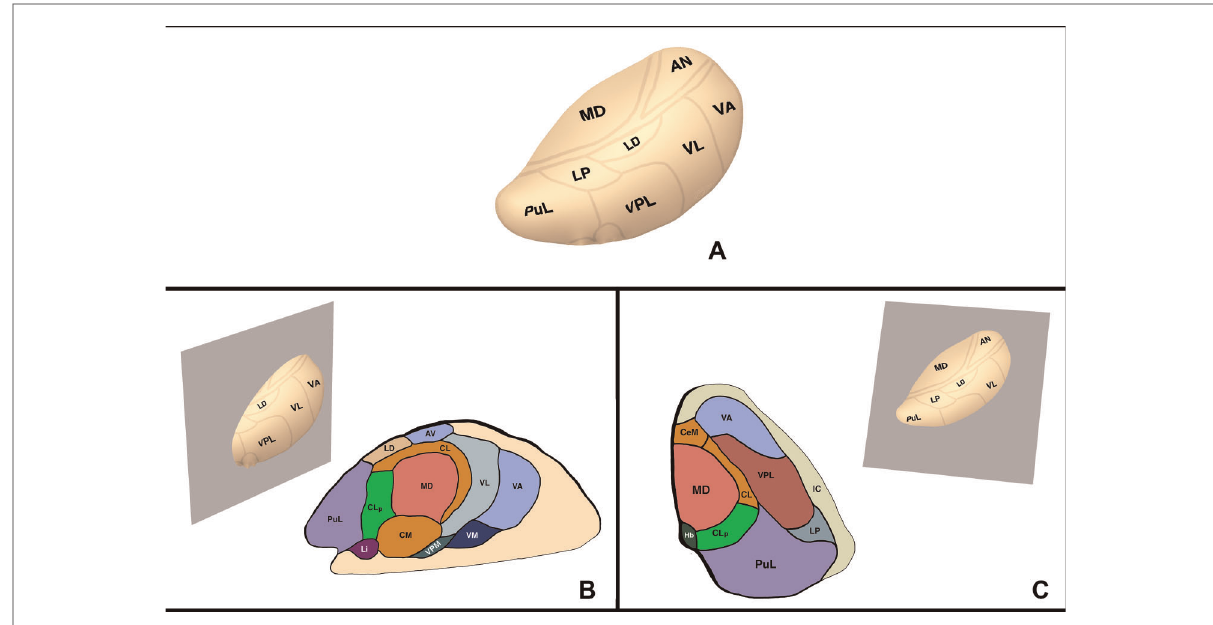
FIGURE 2 Thalamic anatomy. (A) External view. ( B ) Sagittal plane of the thalamus through the CLp. ( C ) Axial plane of the thalamus through the CLp. AV, anterior ventral nucleus; CM, centre median nucleus, CeM, central medial nucleus; CL, central lateral nucleus; CLp, posterior central lateral nucleus; Hb, habenular nucleus; LD, lateral dorsal nucleus; Li, limitans nucleus; LP, lateral posterior nucleus; MD, mediodorsal nucleus; PuL, pulvinar; VA, ventral anterior nucleus; VM, ventral medial nucleus; VPM, ventral posterior medial nucleus; VPL, ventral posterior lateral